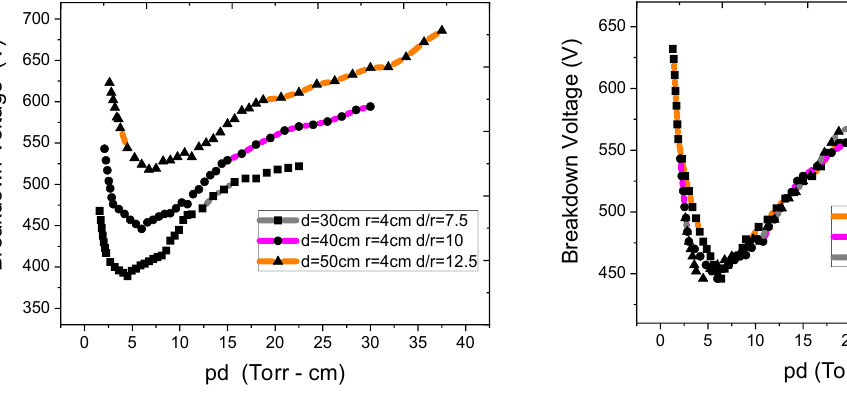
Figure 2: Paschen’s curves for constant electrode radius ( r ) and varying inter-electrode distance ( d ).